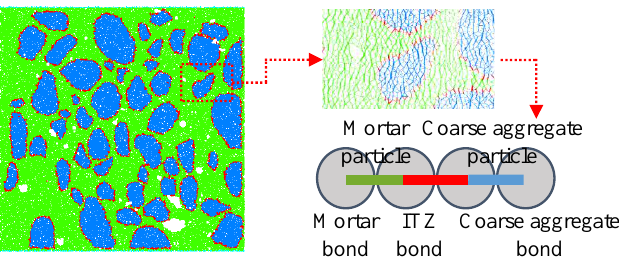
Figure 3. Bonds in concrete model.